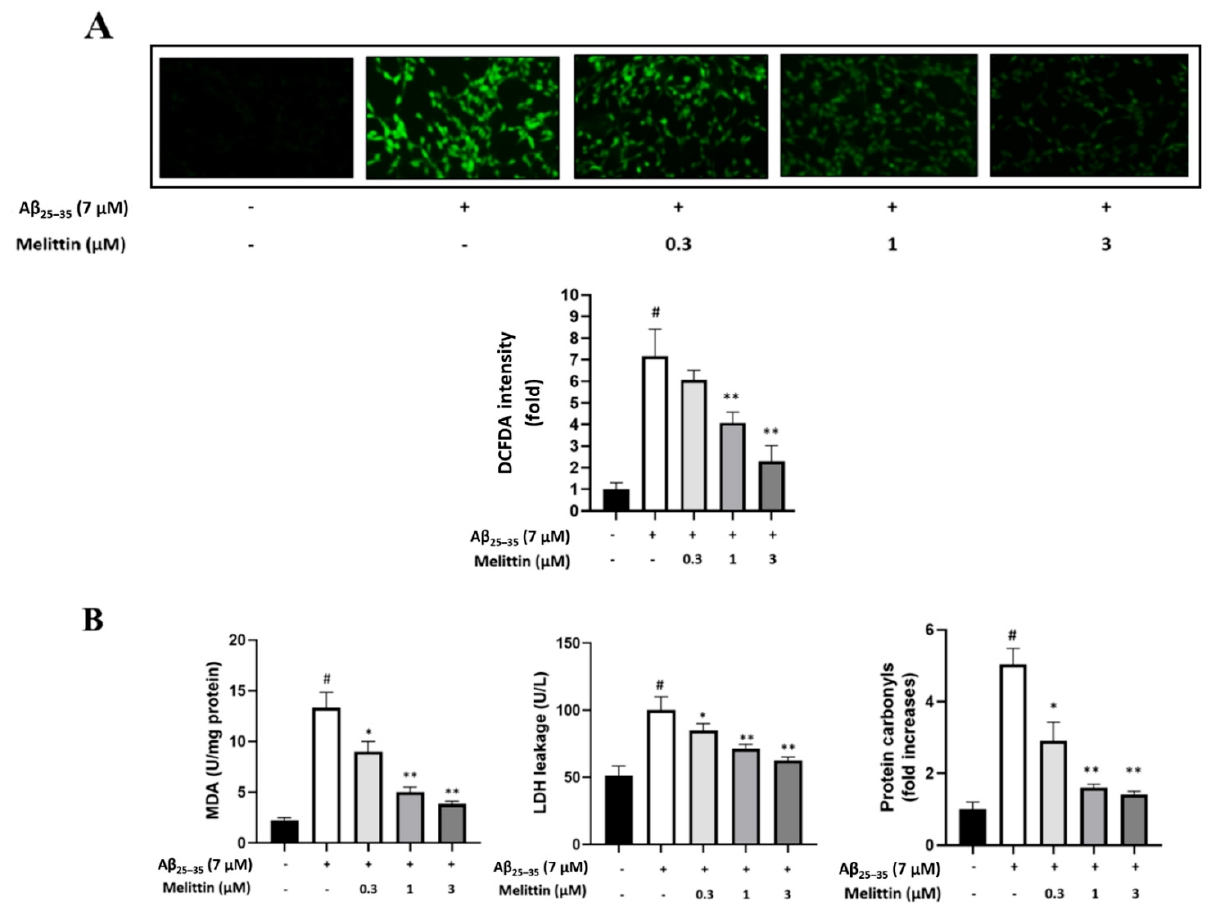
Figure 3. Melittin regulates cellular oxidative stress induced by A β 25–35 in HT22 cells. ( A ) Immunofluorescence analysis to determine the cellular ROS rate. The result indicated that melittin at 0.3 to 3 μ M dosage-dependently normalized the expression of pro and anti-apoptosis proteins under A β 25–35 stress challenge. To conduct this experiment: Seven hours after A β 25–35 (7 μ M) challenge in 96-well plates, immunofluorescence analysis by DCFDA staining was carried out. ( B ) Cellular MDA, LDH, and protein carbonyls levels. The result indicated that melittin at 0.3 to 3 μ M dosage-dependently down-regulated MDA, LDH, and protein carbonyl parameters under A β 25–35 stress challenge. To conduct this experiment: Seven hours after A β 25–35 (7 µ M) challenge in 6-well plates, kits measuring MDA, LDH, and protein carbonyls were used to determine the parameters. Data are presented as mean ± standard deviation values of triple determinations. # p < 0.01 vs. control * p < 0.05 and ** p < 0.01 vs. A β 25–35 only-treated group.